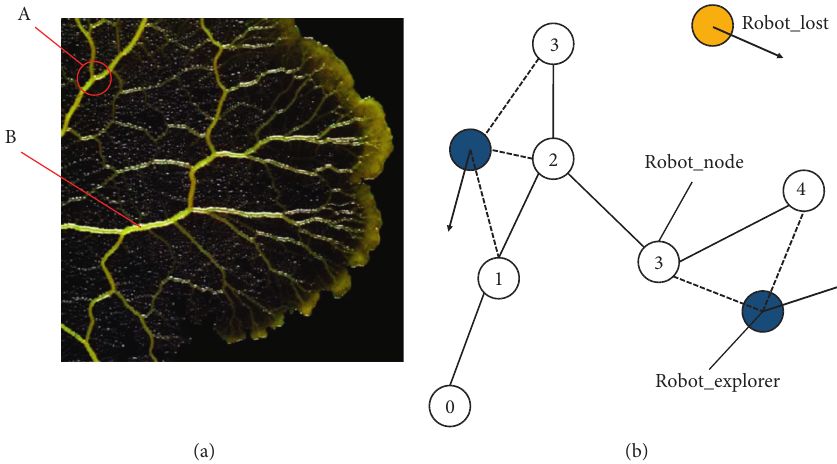
Figure 5: The networks constructed by Physarum polycephalum and swarm robots. (a) Created by Physarum polycephalum . A: a location where tubes intersect, called a node; B: one of the tubes that make up the network. (b) Created by swarm robots: the dotted and solid lines represent connections to the valid communication neighbours of a Robot_Explorer and a Robot_Node, respectively; the numbers represent the gradient value of each Robot_Node; and the arrows point in the direction of each robot’s current